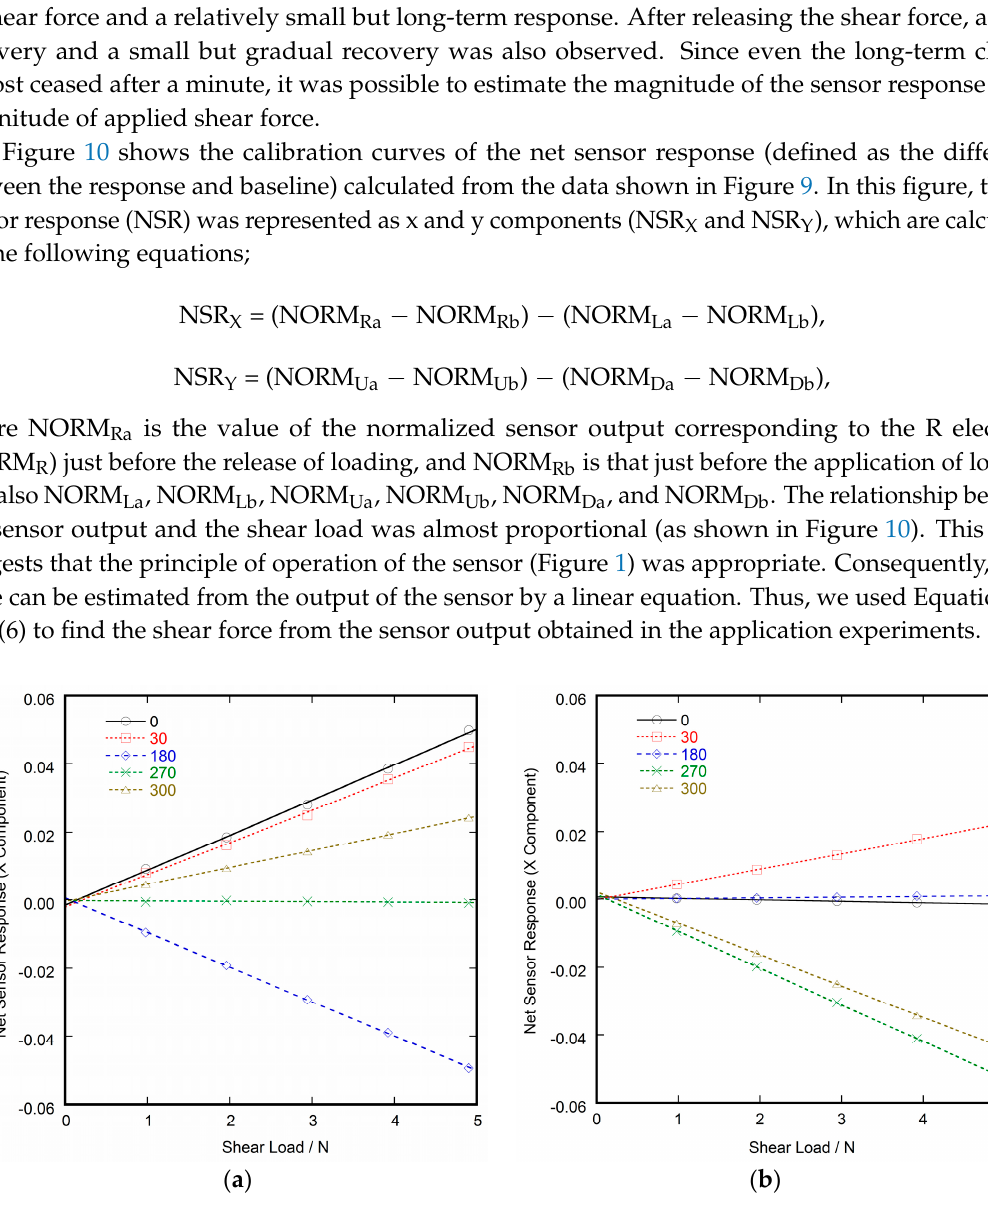
Figure 10. Relation between the component expression of the sensor output and the magnitude of the applied shear force. The data shown in this figure were calculated from the data in Figure 9. Each line corresponds to the shear force with different direction angles. The lines are the results of least squares fitting. The number of each legend indicates the direction angle. ( a ) Shear force component of x-direction; and ( b ) Shear force component of y-direction.